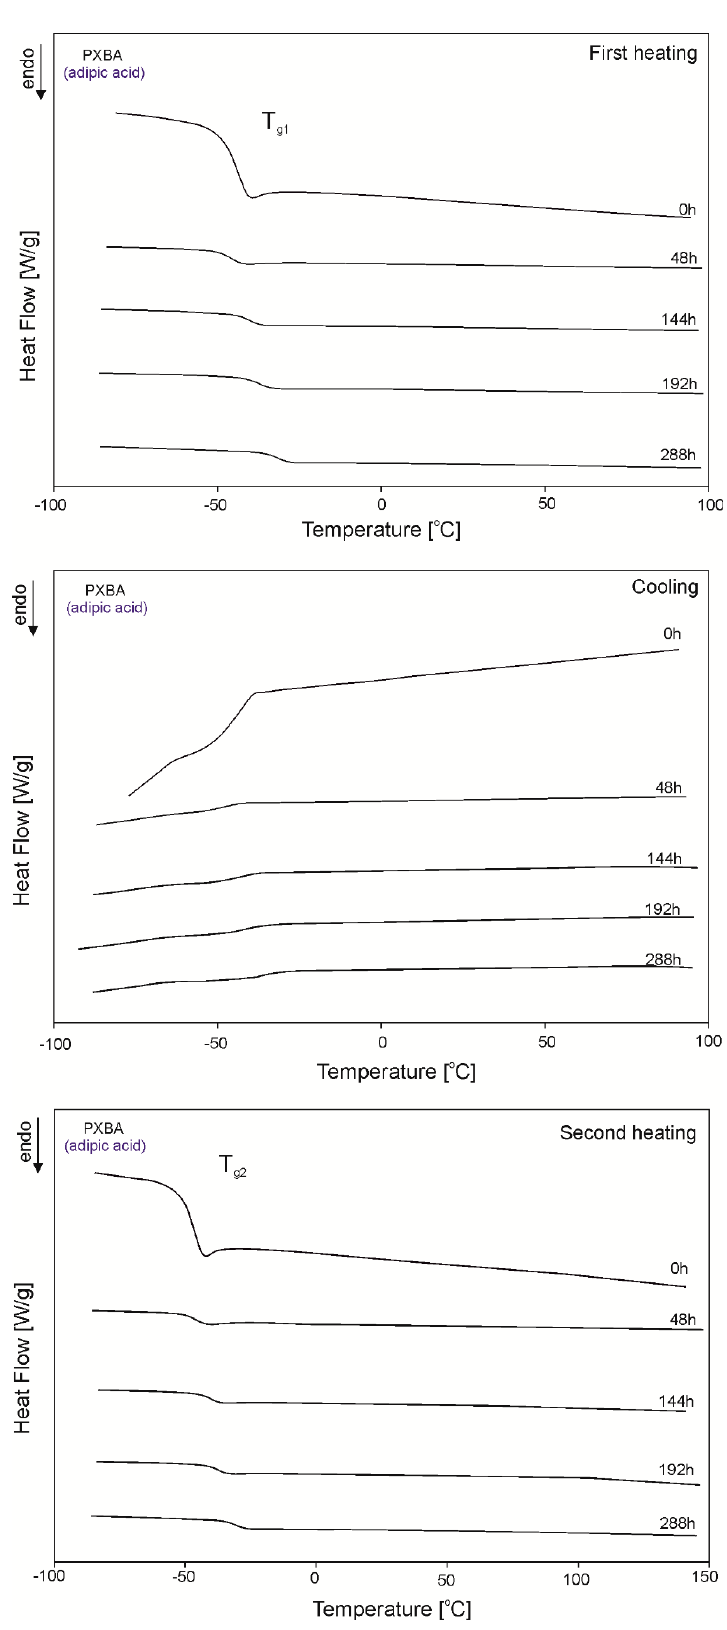
Figure 6. DSC thermograms of PXBA at the crosslinking stages subjected to first heating, second heating and